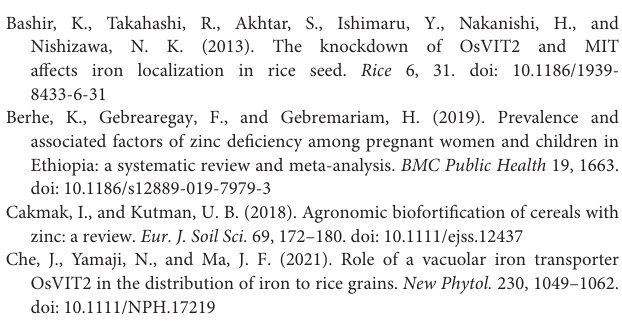
FIGURE 3 | sequence spectrum. Thymine in WT is changed to Adenine in 1095_k at the third exon of OsVIT2 . (B) The mRNA expression of OsVIT2 relative to the UBQ gene in shoot and root samples from WT and 1095_k. Plants were grown for 1 week in normal Kimura’s B solution. Significant differences were calculated using Student’s t -test. *** p < 0.001. Error bar = SD. n = 3. (C) Fe and Zn concentration of WT and 1095_k in brown rice. Plants were cultivated in the rice field of the Yayoi campus, The University of Tokyo. Significant differences were calculated using Student’s t -test. * p < 0.05, *** p < 0.001. Error bar = SD. (D) A correlation plot between Fe and Zn concentration in brown rice for each genotype in the F2 population. F2 plants were grown together with parental line (C) and Inductive Coupled Plasma Mass Spectrometry (ICP-MS) analysis was performed. WT and 1095_k are the same data as in (C, E) Boxplot of different F2 genotypes in (C) . Significant differences were calculated using Tukey’s HSD ( p < 0.05). Letters indicate significant differences. The number of replicates is shown in